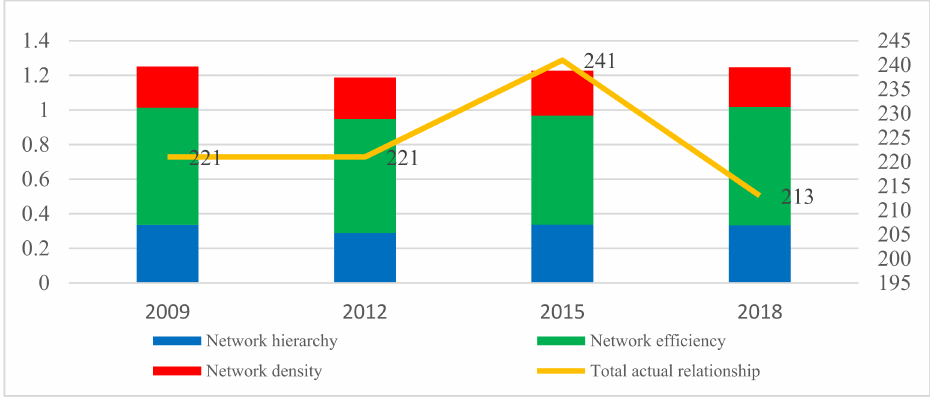
Figure 3. Characteristic pattern of the overall network structure of allocation